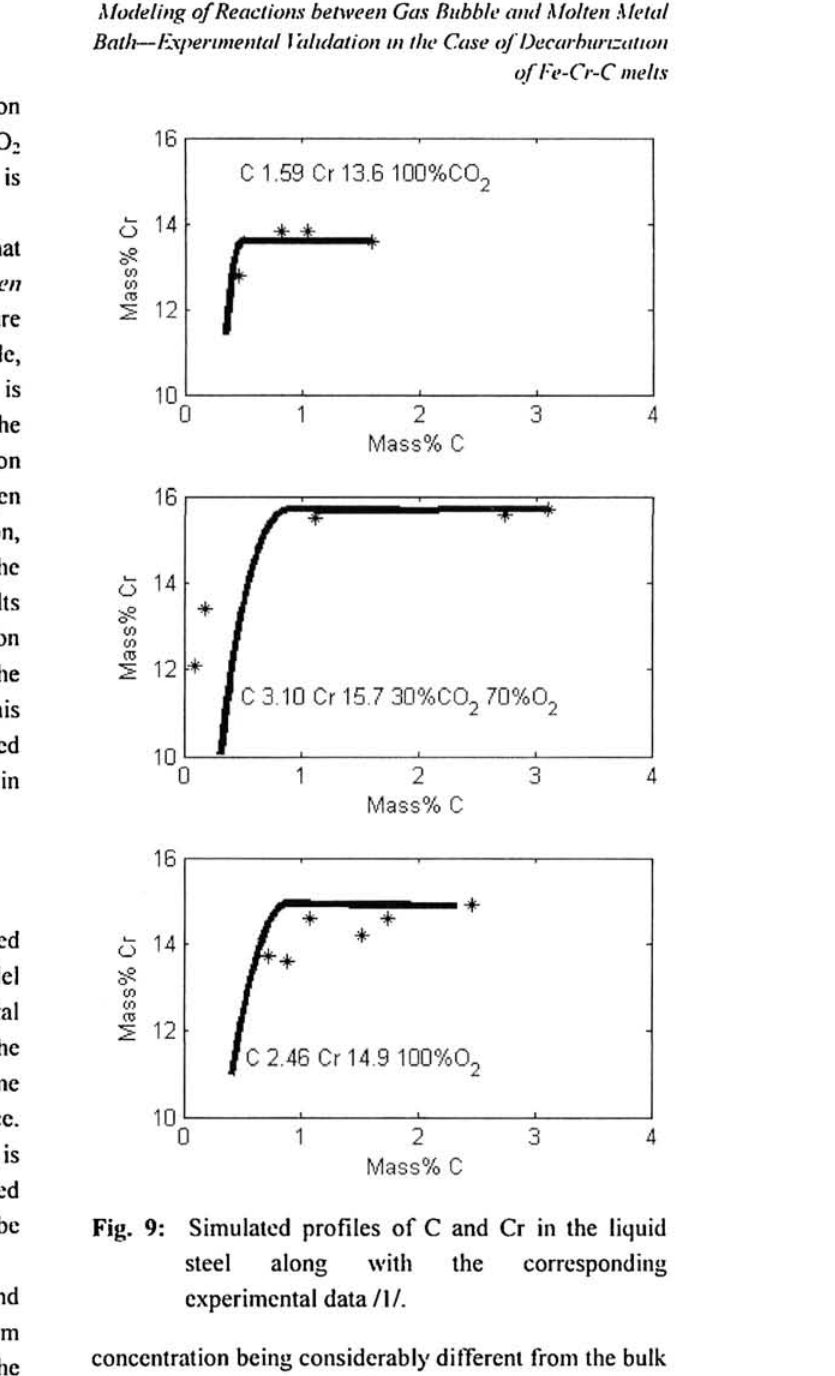
Fig. 9: Simulated profiles of C and Cr in the liquid steel along with the corresponding experimental